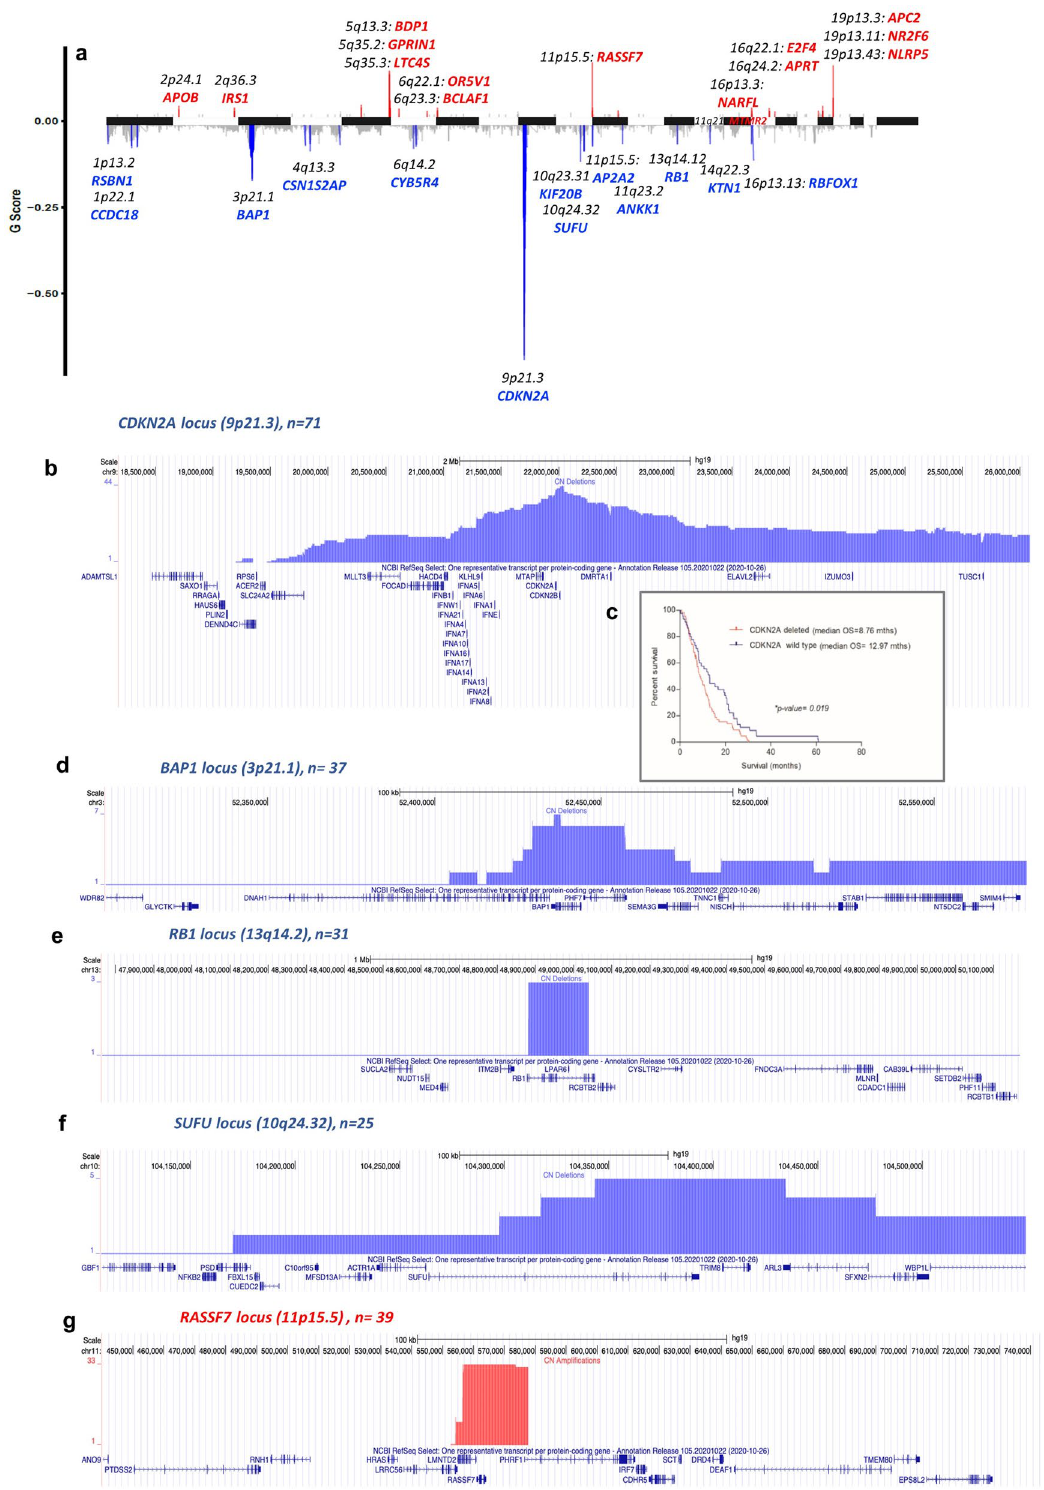
Figure 1. Mapping of copy number alterations in subjects with pleural mesothelioma. ( a ) Statistically significant regions of amplification and deletion from GISTIC analysis of 118 subjects. Peak regions which pass both the G-Score ( Gistic score in ver.2.0 is defined as the negative logarithm of the probability of observing a candidate copy-number segment with given amplitude and frequency, provided the background copy-number alteration rate) and q-bound (< 0.05) threshold cut-offs are shown for deletions (blue) and amplifications (red) (see also Supplementary File 1_Table 3 and Supplementary File 2_Table 5B for the extensive list of copy-number segment coordinates for each sample); ( b ) Detailed map of the CDKN2A locus using the UCSC Genome Browser (hg19), showing histogram representation of overlap among deletion segments from the 118 subjects. IFN Type I genes are commonly within the deleted segments; ( c ) Kaplan–Meier survival analysis of patients with and without CDKN2A locus deletions; ( d - f ) Similar Genome Browser based maps of the BAP1 , RB1 and SUFU deleted segments; ( g ) Map for amplification segments from the RASSF7